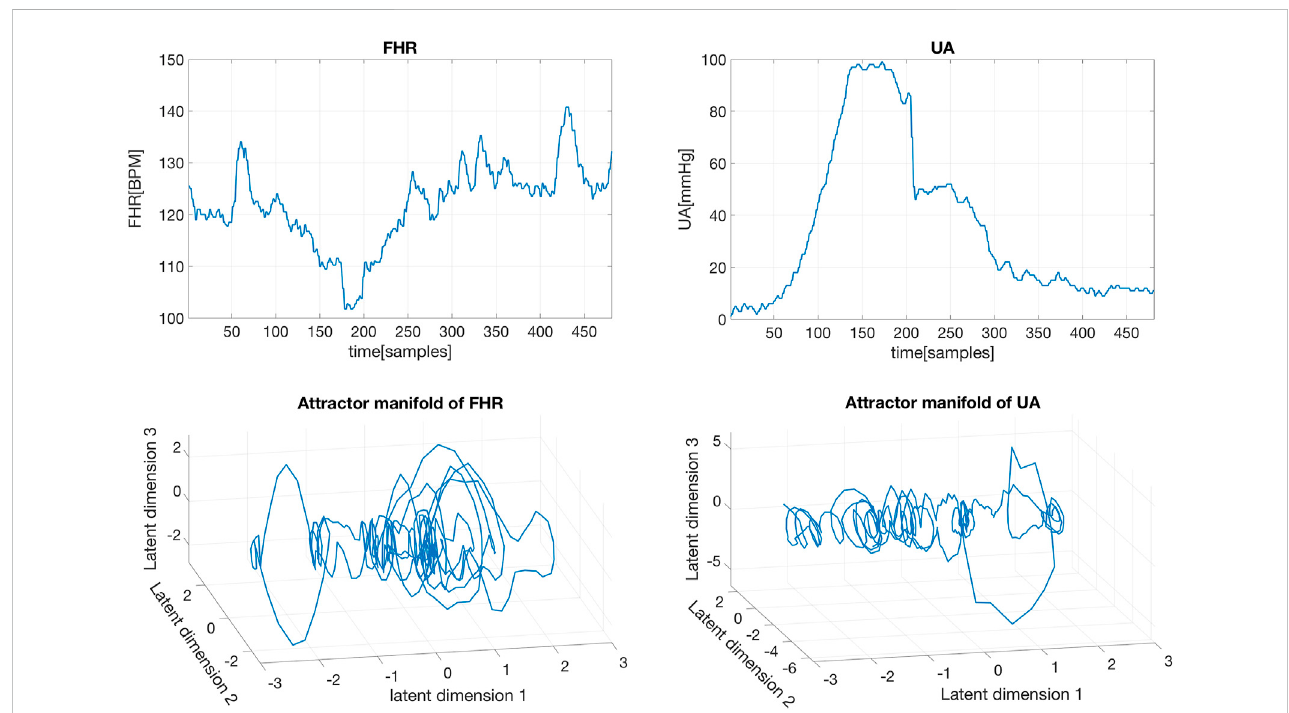
FIGURE 4 Raw FHR and UA segments (top), and their corresponding reconstructed attractor manifolds with the GP-based method